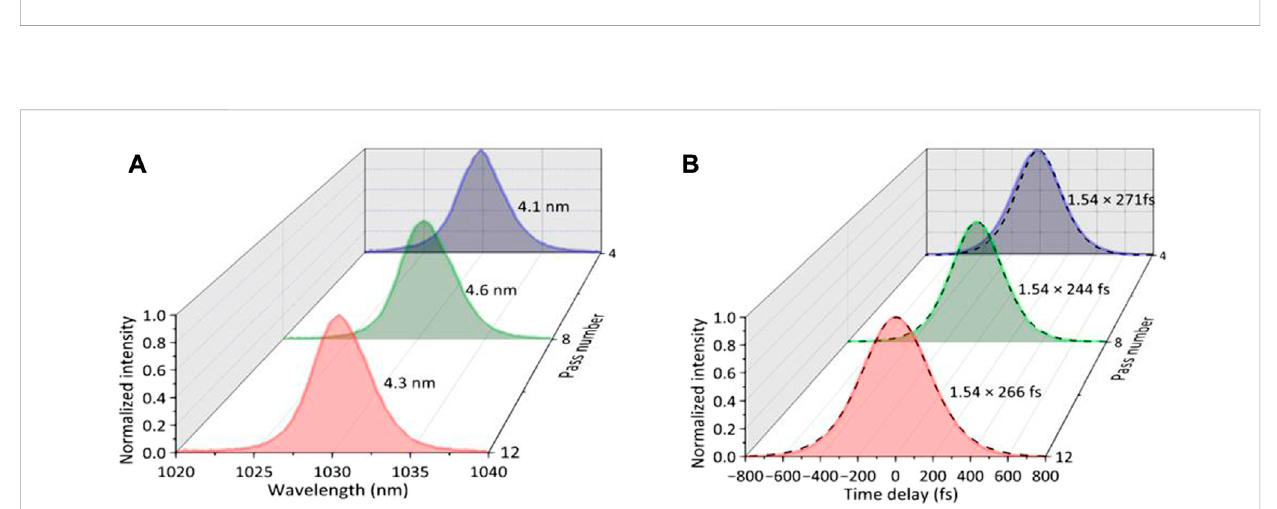
FIGURE 3 Spectra (A) and pulse durations (B) of the KLM Yb:YAG oscillator depicted in Figure 2 with passes of four, eight, and twelve.